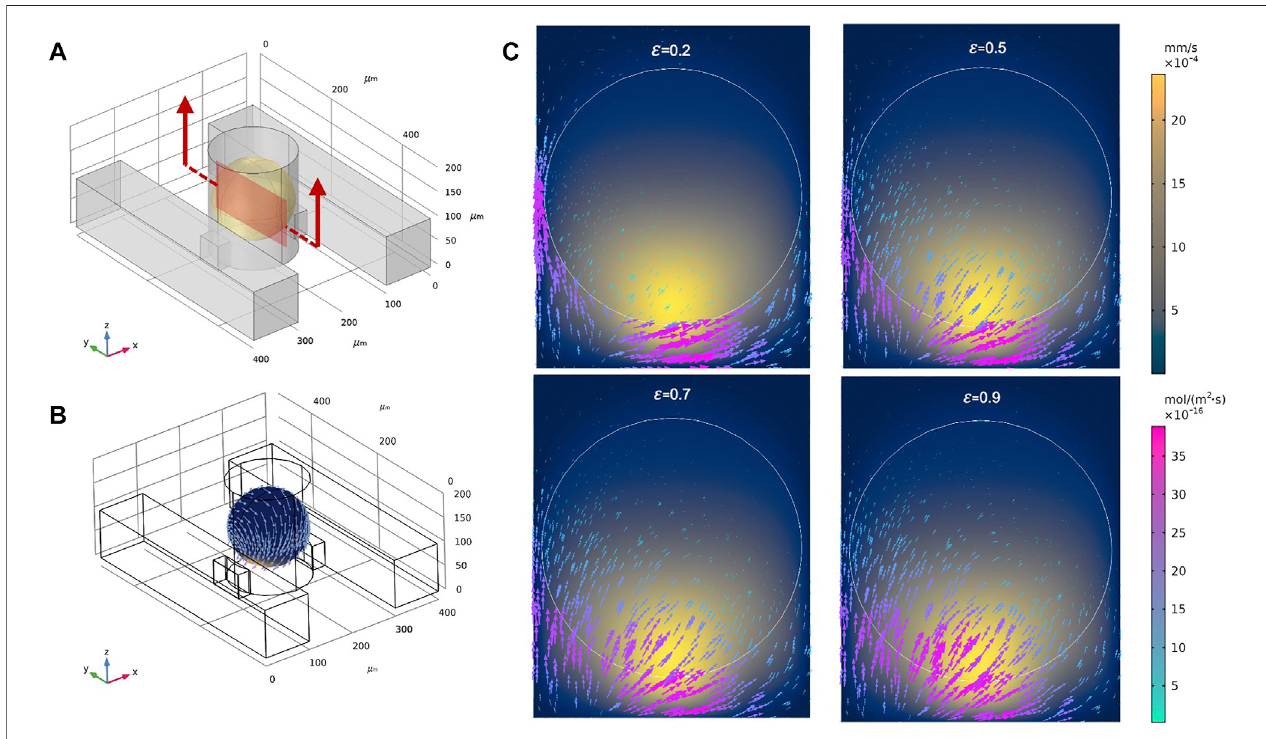
FIGURE 5 | Total molecular fl ux and velocity magnitudes for different spheroid porosities. (A) A single unit of the double-supply channel (DSC) design of the spheroid-on-a-chip device, where the de fi ned cross-section represents the sagittal yz-plane. (B) 3D contours of velocity magnitude and 3D vectors of drug fl ux around the spheroid when φ (cid:2) 0.9. (C) Velocity magnitudes (2D surface plot) and vectors of drug fl ux within the sagittal yz-plane for φ (cid:2) 0.2, 0.5, 0.7, and 0.9.